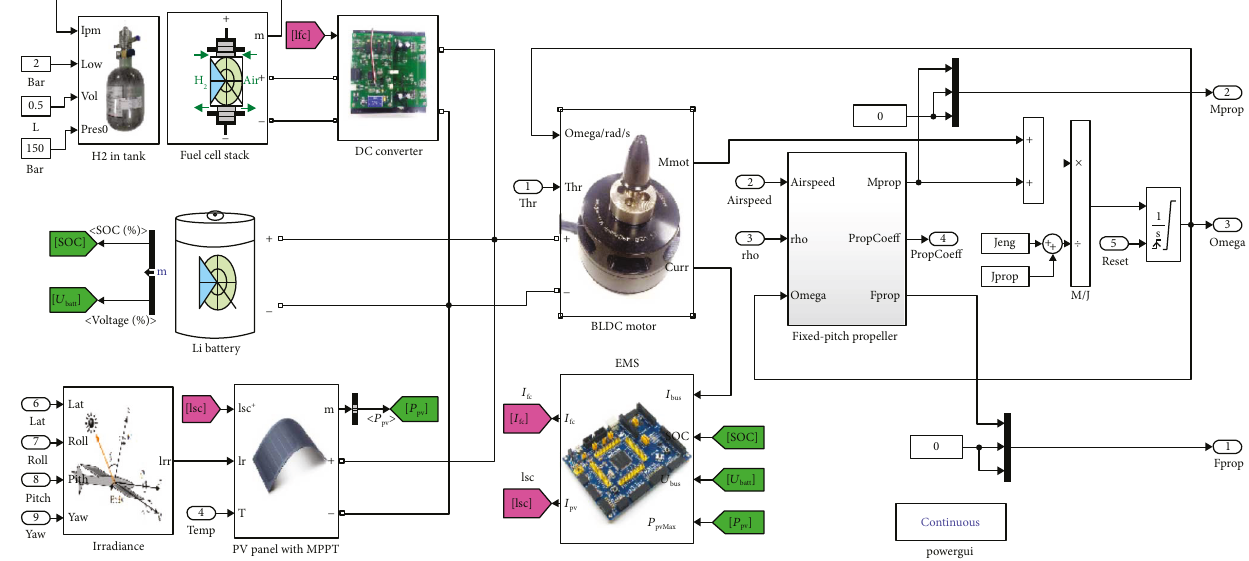
Figure 5: Topology of the hybrid power